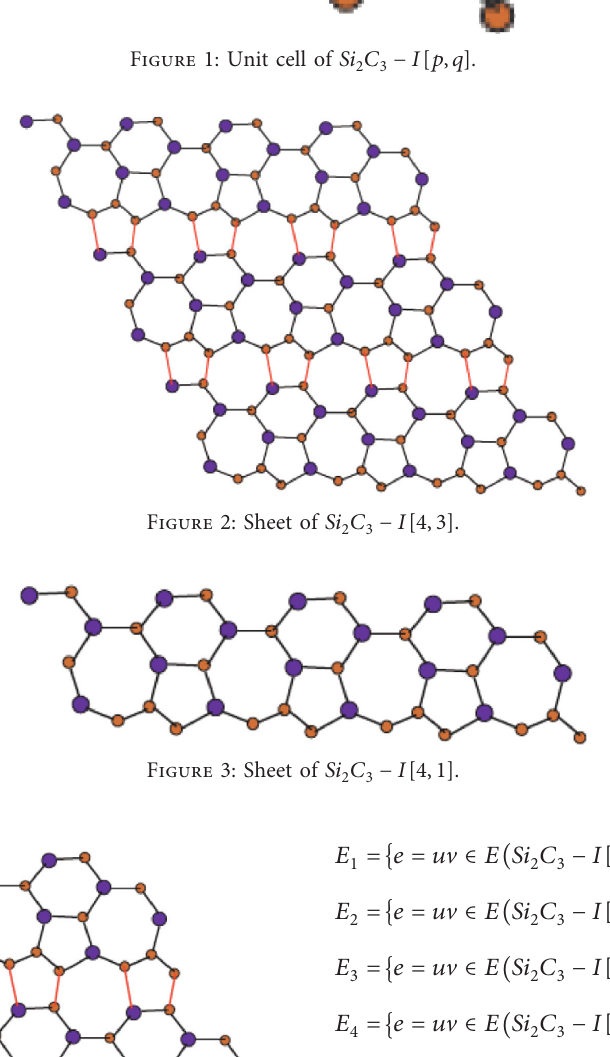
Figure 1: Unit cell of Si